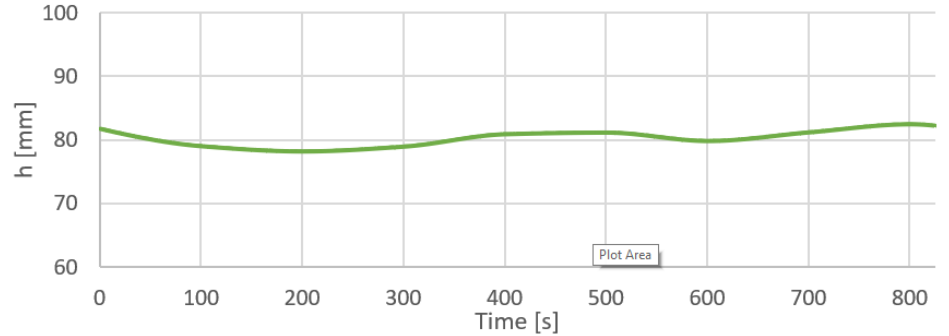
Figure 7. Waveform of changes in the position of the distribution layer in compartment 3 when using the traditional PID controller.